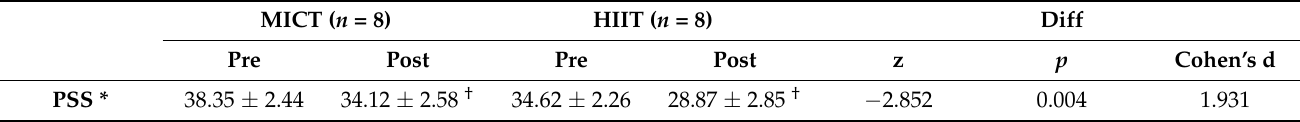
Table 7. Perceived stress scale in MICT and HIIT groups.